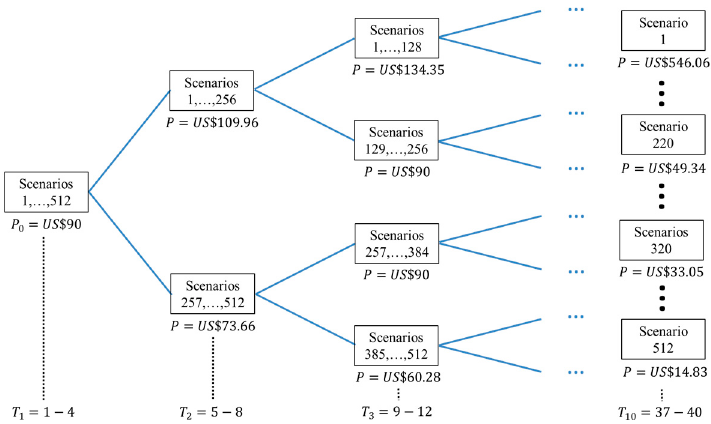
Figure 4. Number of scenarios and price (per bbl) variation in crude oil binomial tree.